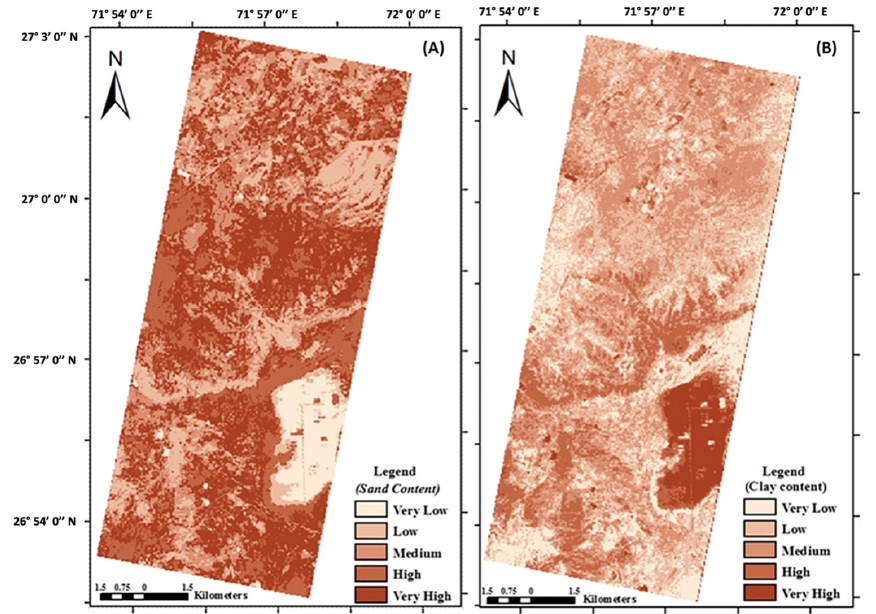
Figure 4. Soil ( a ) sand and ( b ) clay content in northwestern India as estimated from Earth Observing-1 (EO-1) Hyperion. These spatial data demonstrate the potential for dryland soil monitoring over time using spaceborne imaging spectrometers [83].